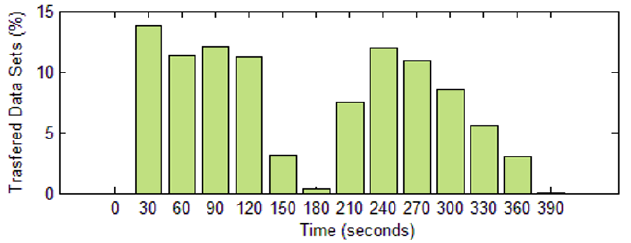
Figure 4. Time distribution of load profile data availability at the MDC tier.